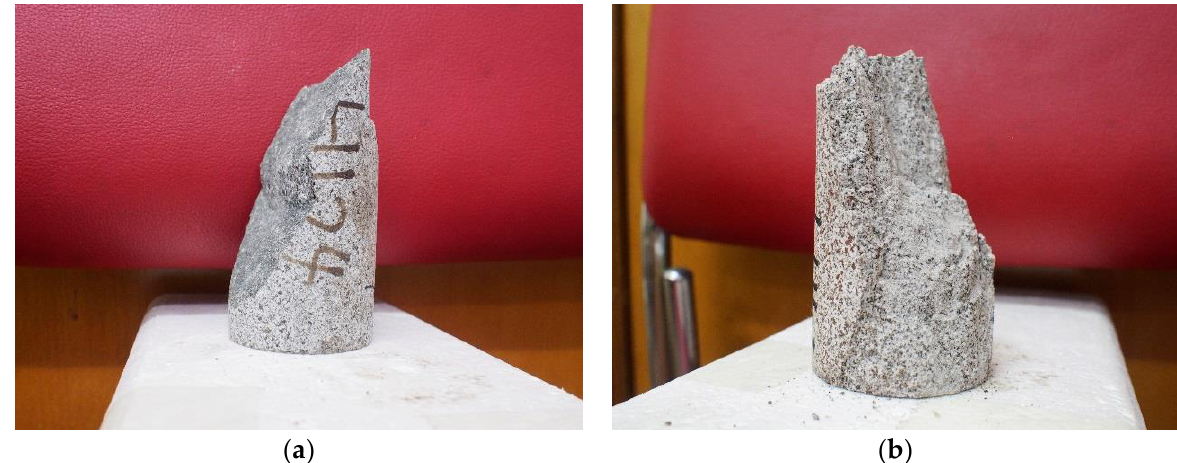
Figure 3. Granite specimens after uniaxial compression tests subjected to heat treatment at ( a ) 200 °C and ( b ) 1000 °C.